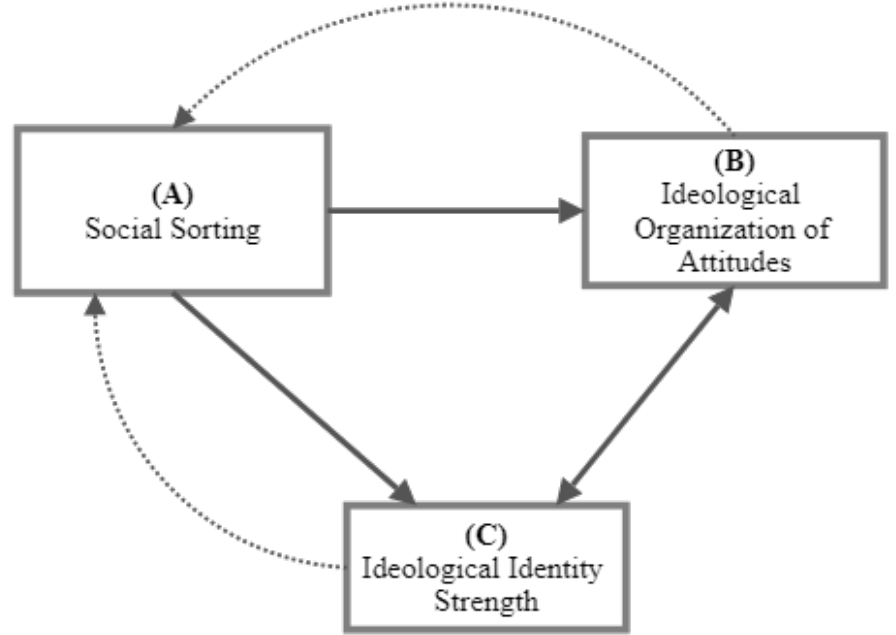
Figure 1: Micro-level pathways of social sorting undergirding polarization. Note: Broken lines represent sociopolitical homophily